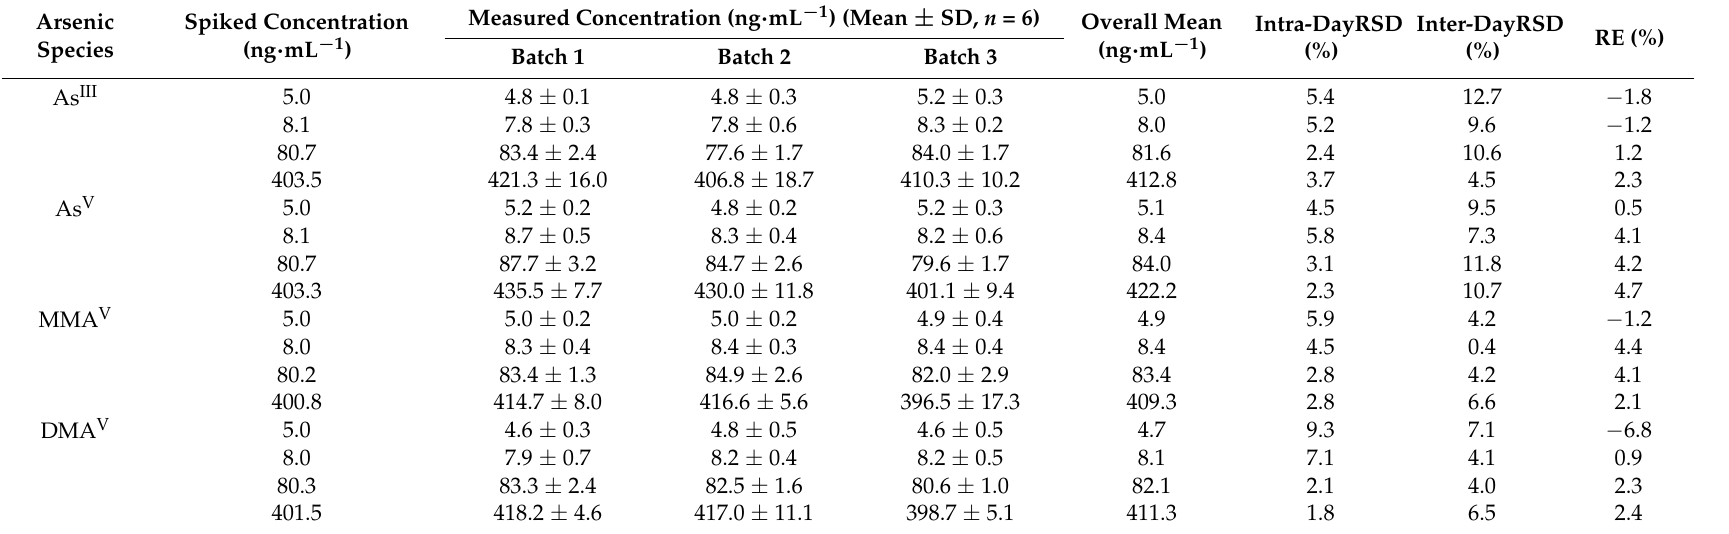
Table 1. Detection precision and accuracy for the four analytes in cynomolgus macaque plasma ( n =